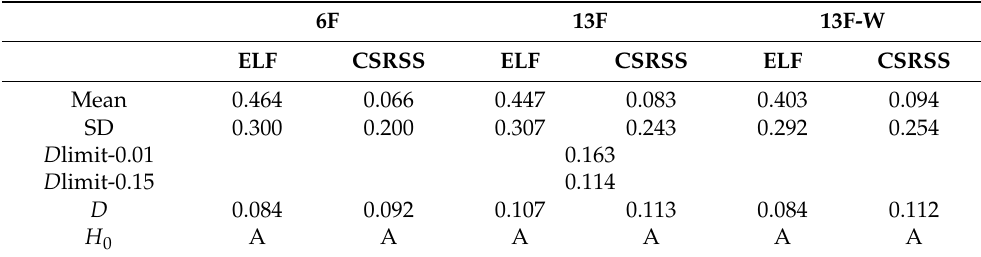
Table 3. Distribution parameters and K-S test results for normal